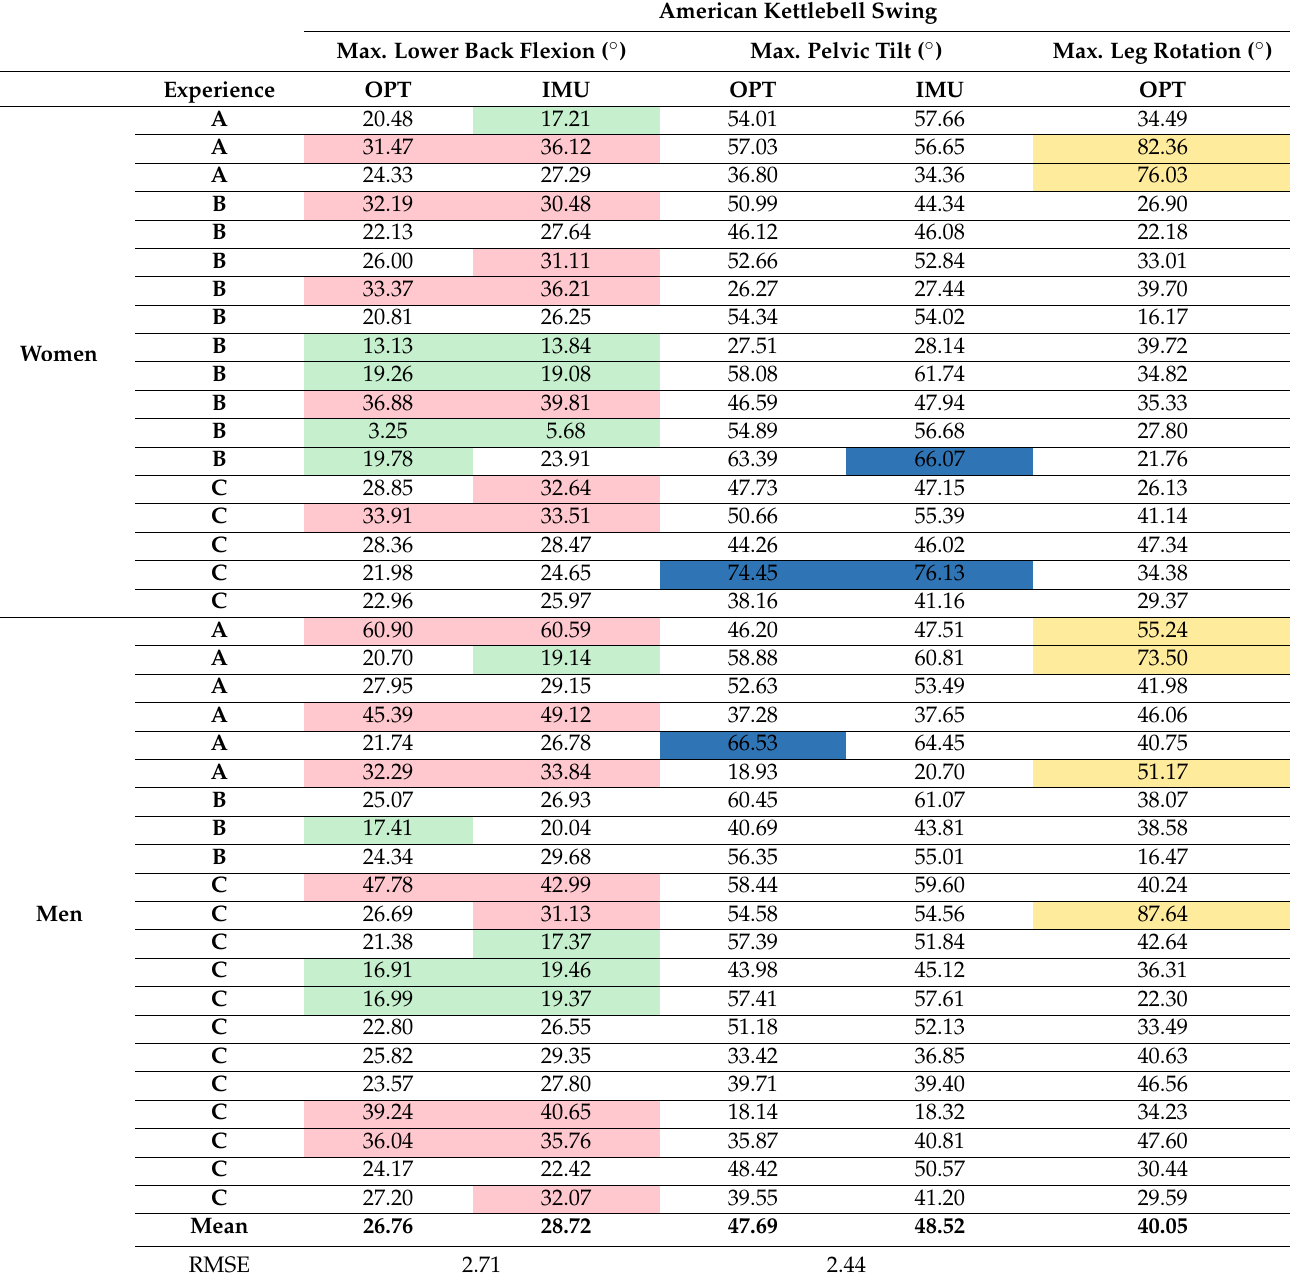
Table 1. Experimental measurements obtained for the American kettlebell swing (lower back flexion >30 ◦ in red and <20 ◦ in green; pelvic tilt >60 ◦ in blue; leg rotation >50 ◦ in